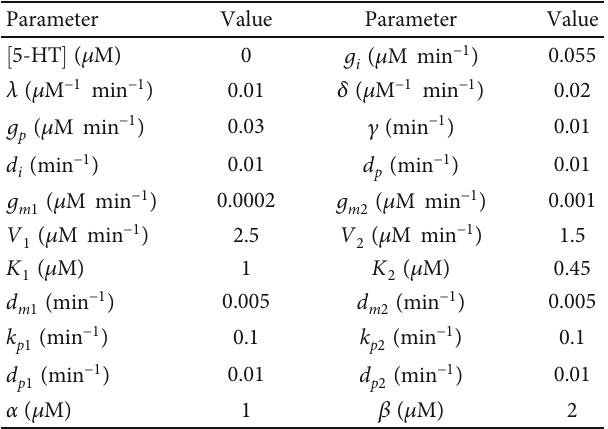
Table 1: Default parameter values of Equations (1) –